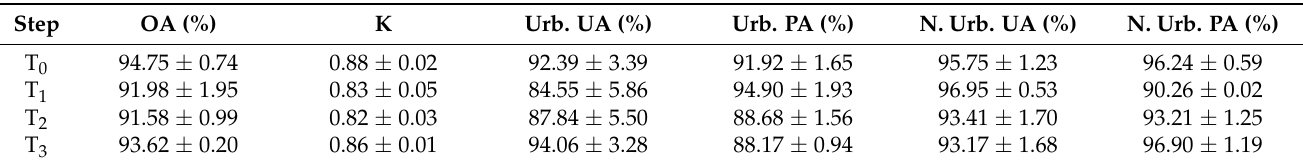
Table 2. Accuracy assessment of urban area extent maps obtained by applying UEXT to CSK data at T 0 , T 1 , T 2 and T 3